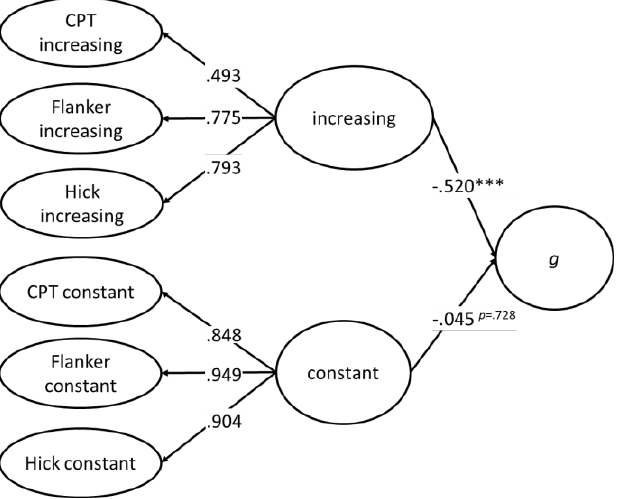
Figure 5. Latent regression analysis of the relationship between the g factor and two second-order latent variables extracted from the flanker task, the continuous performance test (CPT), and the Hick task. Model fit: χ 2SB (48) = 104.243; p < .001; CFI rob = .949; RMSEA = .072; SRMR = .056. *** p < .001 task. Model fit: χ 2 SB (48) = 104.243; p < .001; CFI rob = .949; RMSEA = .072; SRMR = .056. *** p <